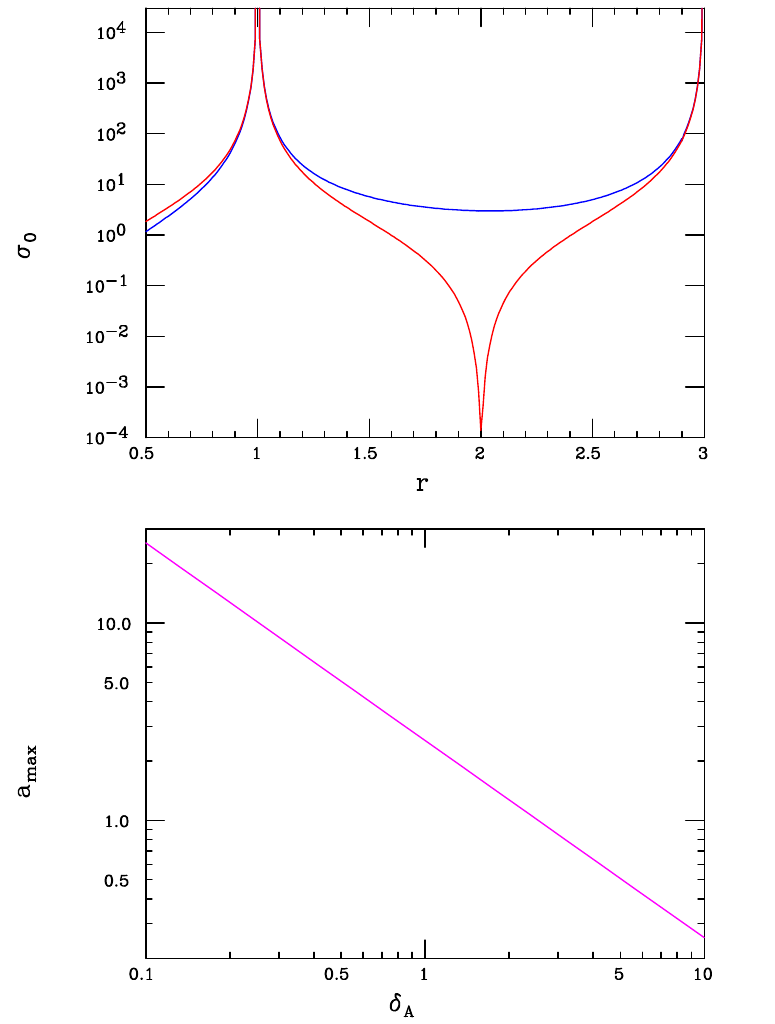
Figure 1 . (Top) T = 0 DM annihilation cross section (in arbitrary units) in the simple toy model discussed in the text. The red (blue) curve corresponds to the case of same-sign (alternating sign) couplings for the DP KK tower. (Bottom) The upper bound on a , i.e., a max as a function of (cid:14) A